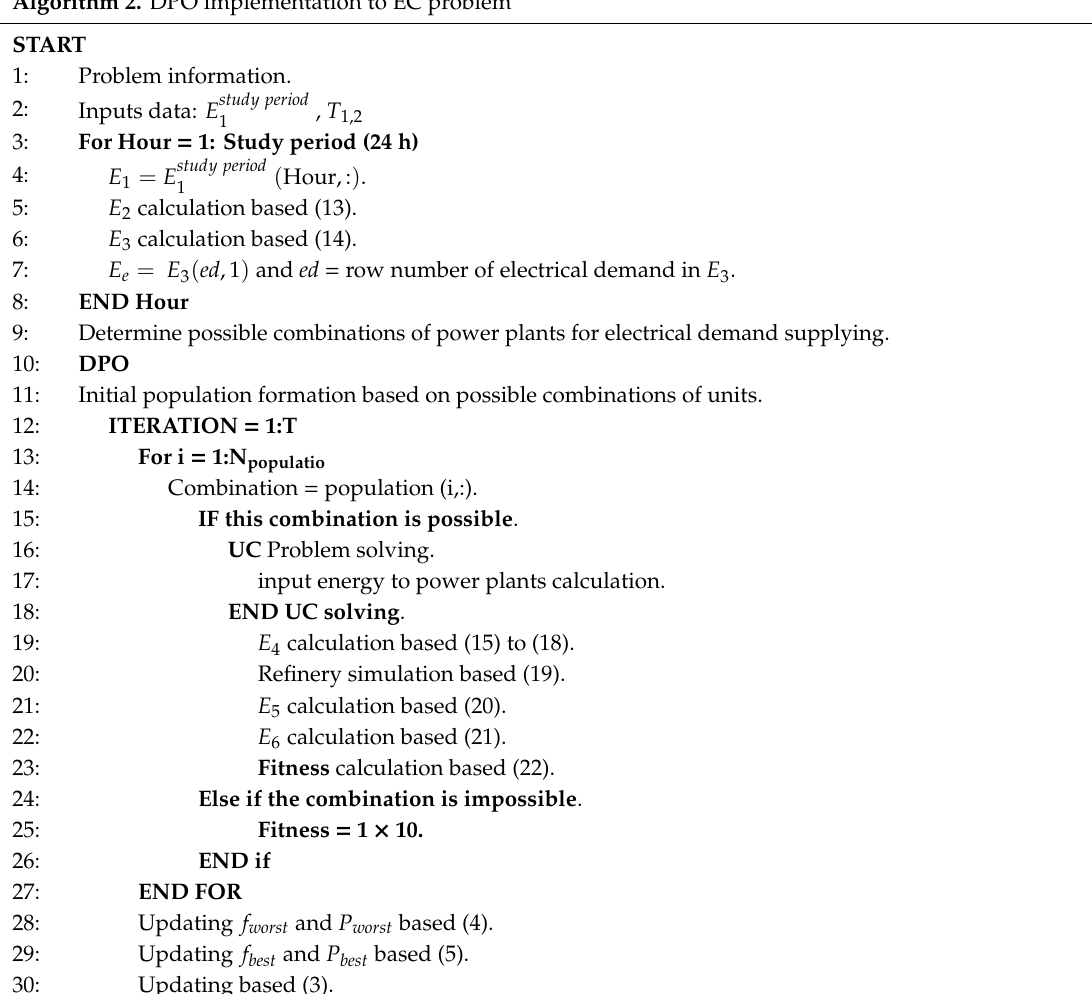
Algorithm 2. DPO implementation to EC